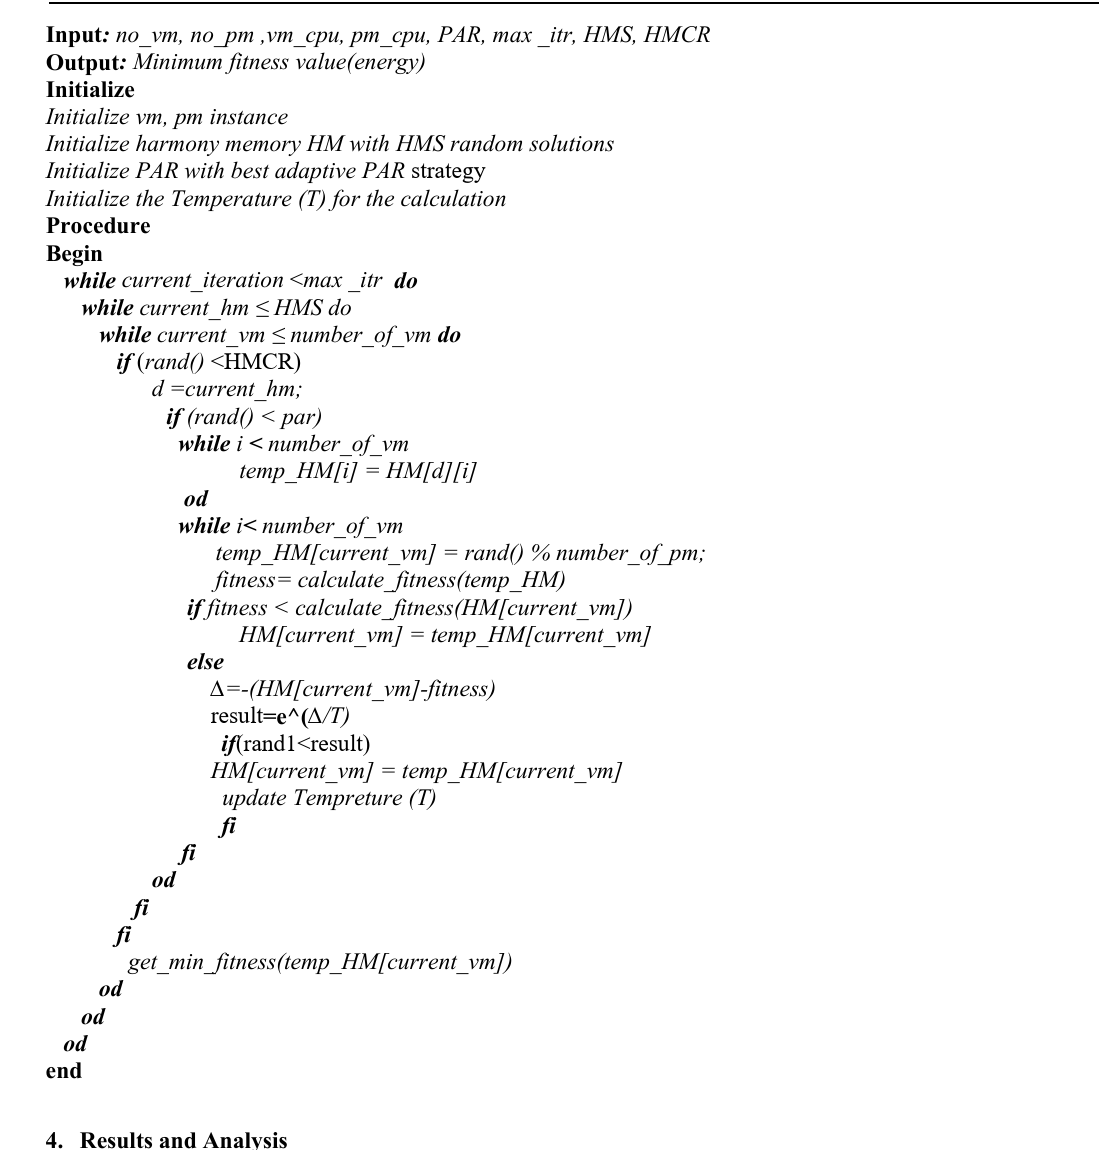
Algorithm 2. Pseudocode for the hybrid HSA with simulated annealing and local